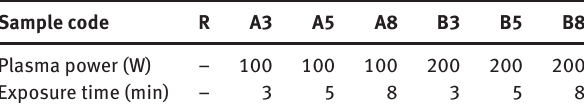
Table 3: Codes and characteristics of the samples. Sample